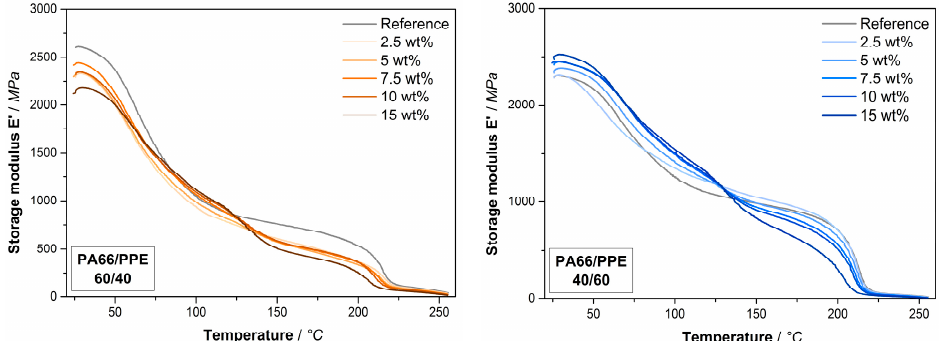
Figure A1. Complex viscosity of neat PA66 (violet rectangular) and neat PPE (green rectangular).